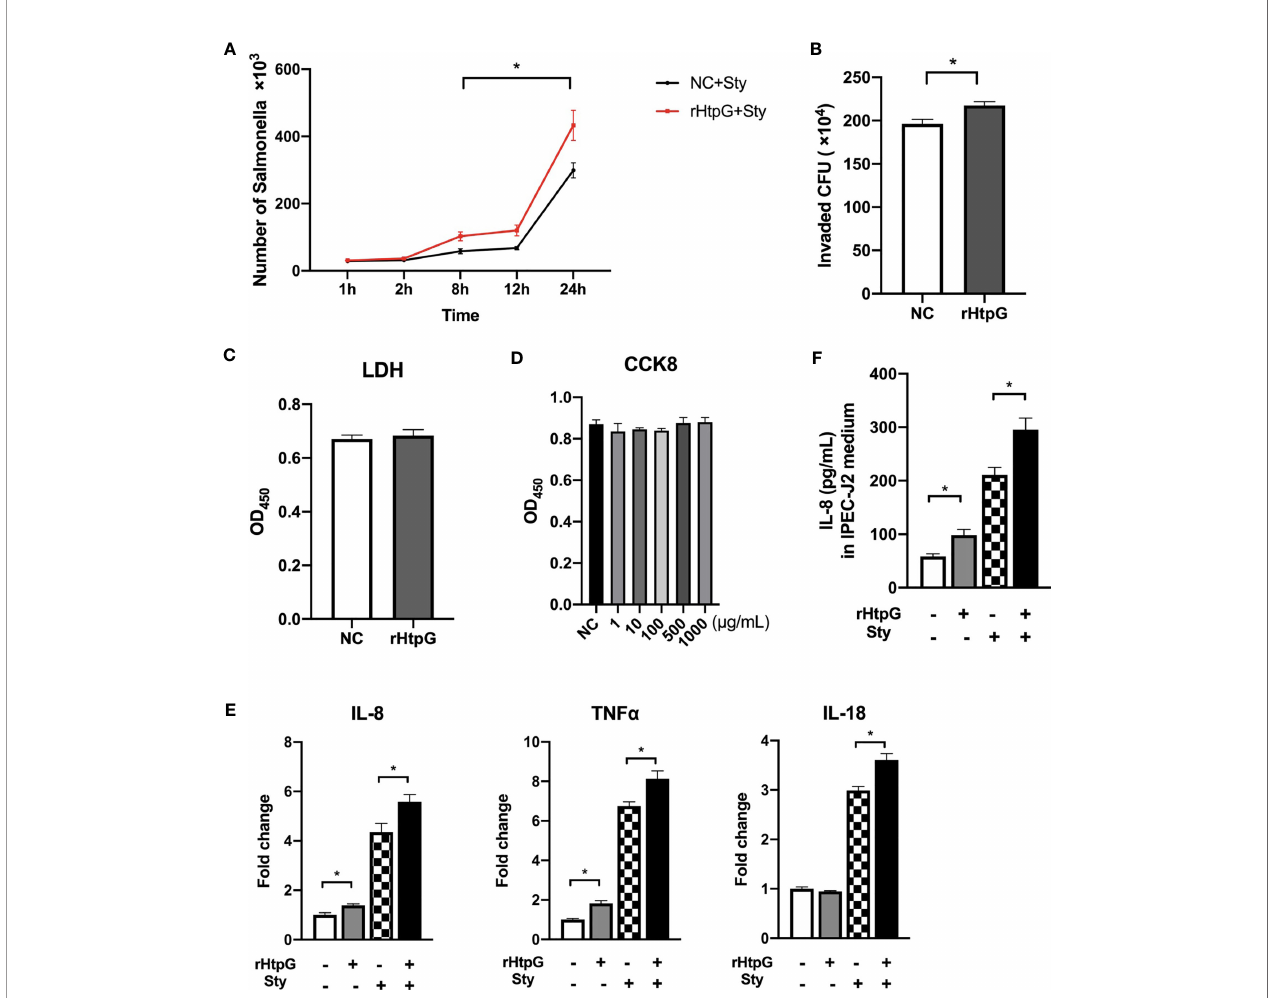
FIGURE 6 | In fl uence of HtpG protein on S. Typhimurium infection. (A) Proliferation of S. Typhimurium in IPEC-J2 cells after rHtpG treatment, n = 4. (B) Number of S. Typhimurium infecting RAW 264.7 cells after rHtpG treatment for 6 h, n = 4. (C) The content of LDH in the cell culture medium after rHtpG treatment for 12 h, n = 6. (D) IPEC-J2 cell proliferation after rHtpG treatment, n = 6. (E) The relative mRNA expression of IPEC-J2 in fl ammatory cytokines, n = 6. (F) The content of IL-8 in IPEC-J2 cells medium after rHtpG treatment for 12 h, n = 6. rHtpG means HtpG Recombinant protein, Sty means S. Typhimurium, * means p <